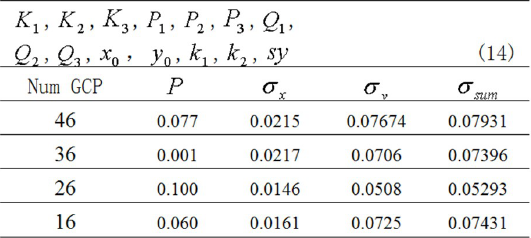
Table 3: The assessment using check points for 14